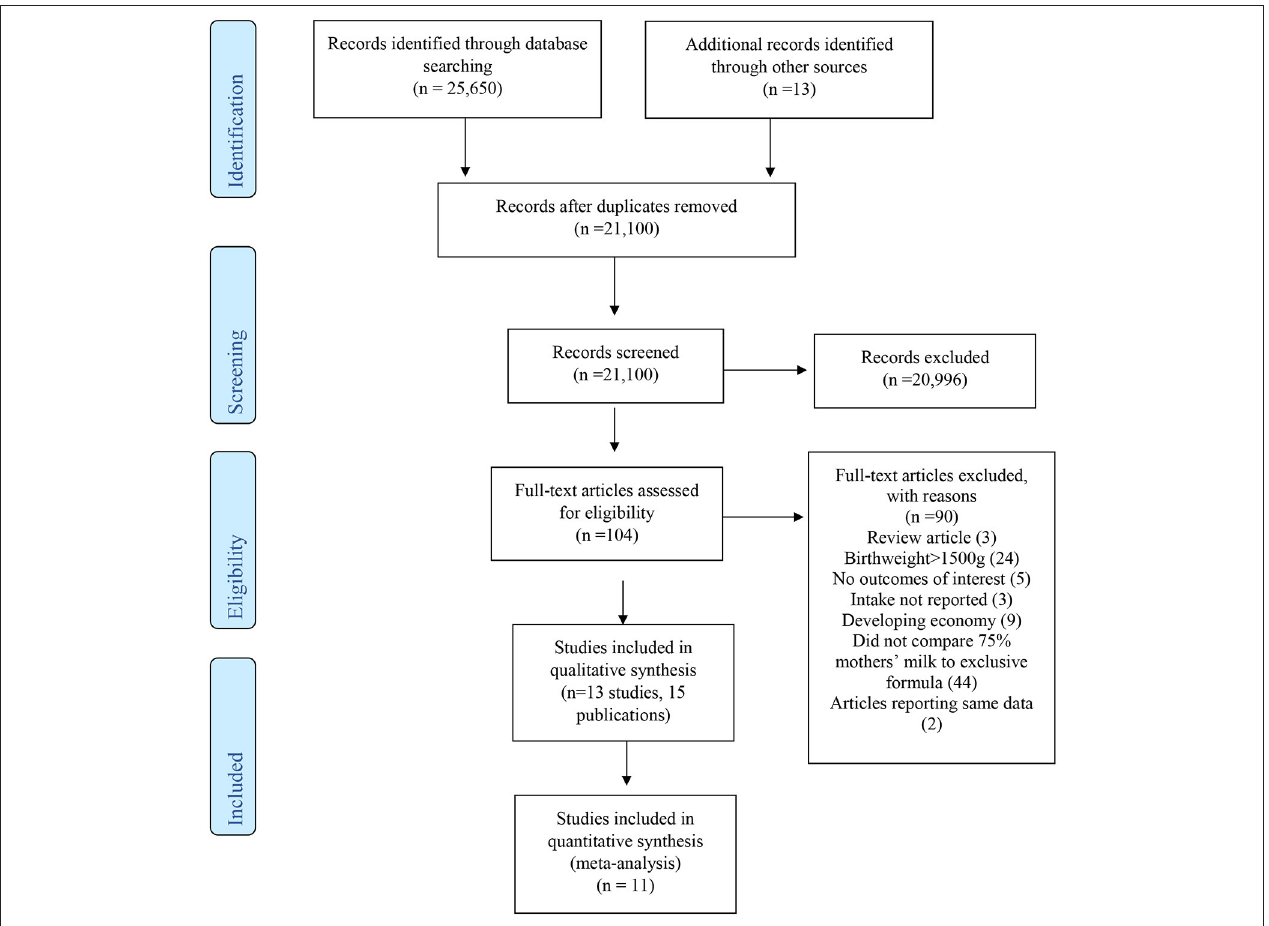
FIGURE 1 | PRISMA flow diagram describing article inclusion for a systematic review examining the question: In VLBW preterm infants ( ≤ 1,500g at birth), what is the association between ≥ 75% MM vs. exclusive formula intake on growth and health outcomes?